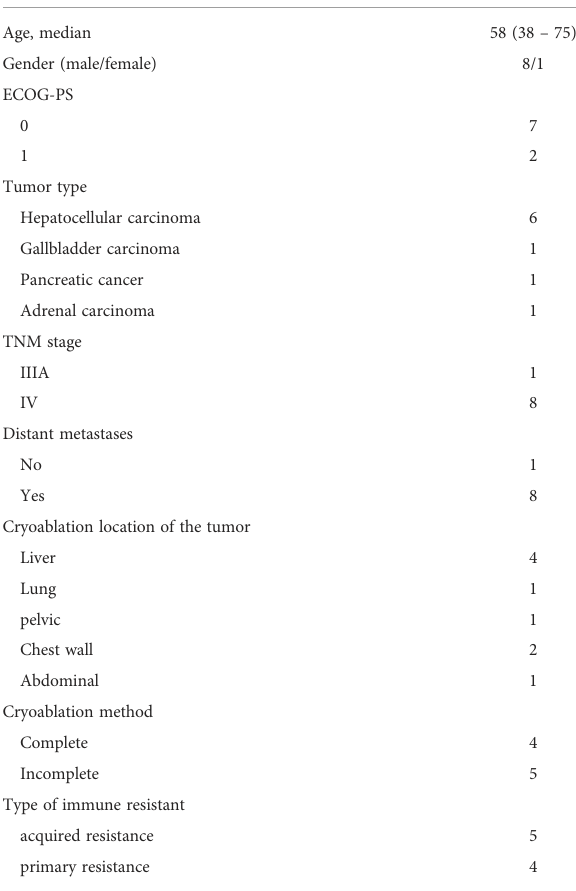
TABLE 1 Baseline characteristics.